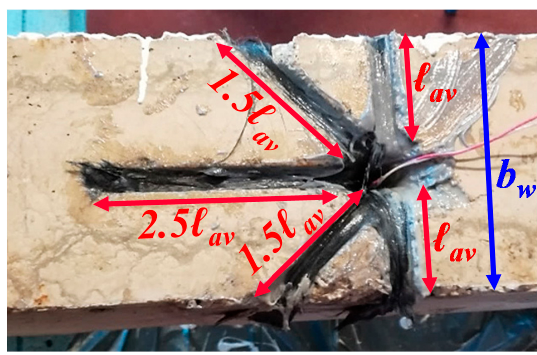
Figure 5. Available and ultimate anchorage lengths of the CFRP ropes at the web width of the beam.